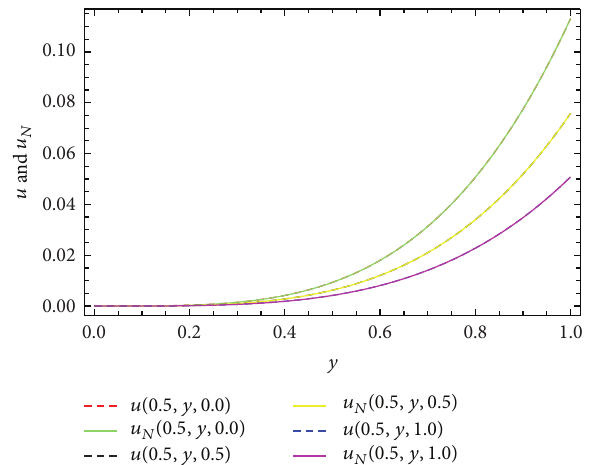
Figure 4: 𝑦 -direction curves of numerical and exact solutions of problem